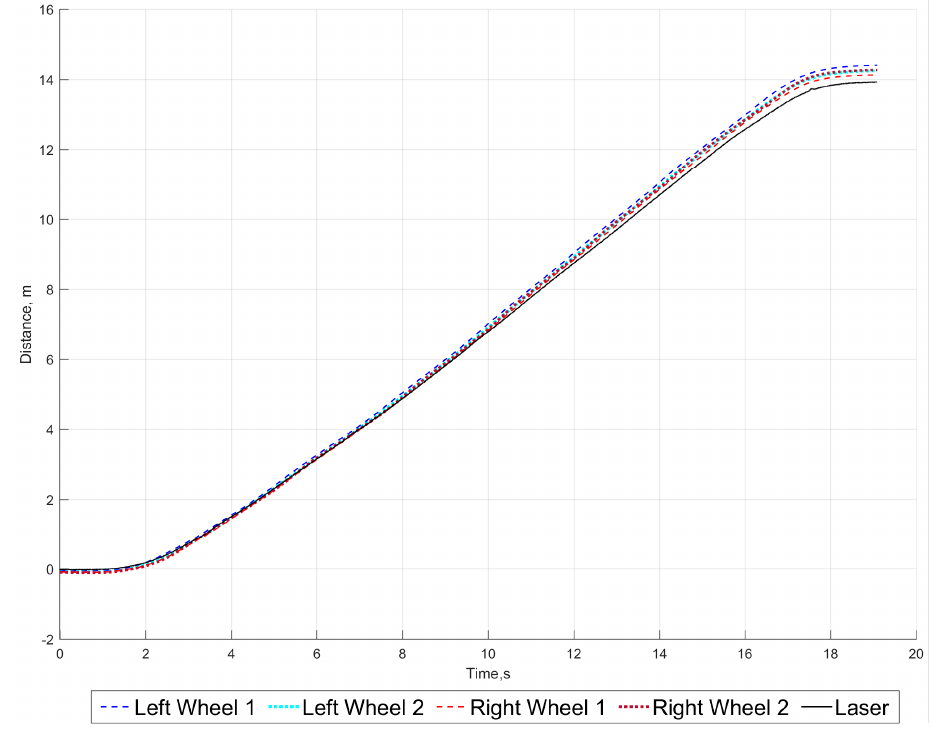
Figure 3. Velocity profile comparison of the four sensors used in trial 1, 14 m.